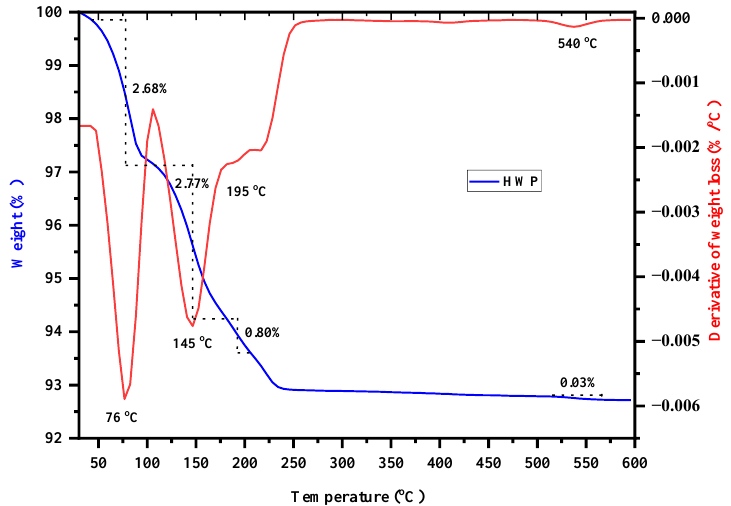
Figure 10. Thermogravimetric analysis (TGA) and derivative thermogravimetry (DTG) analysis of HPW.